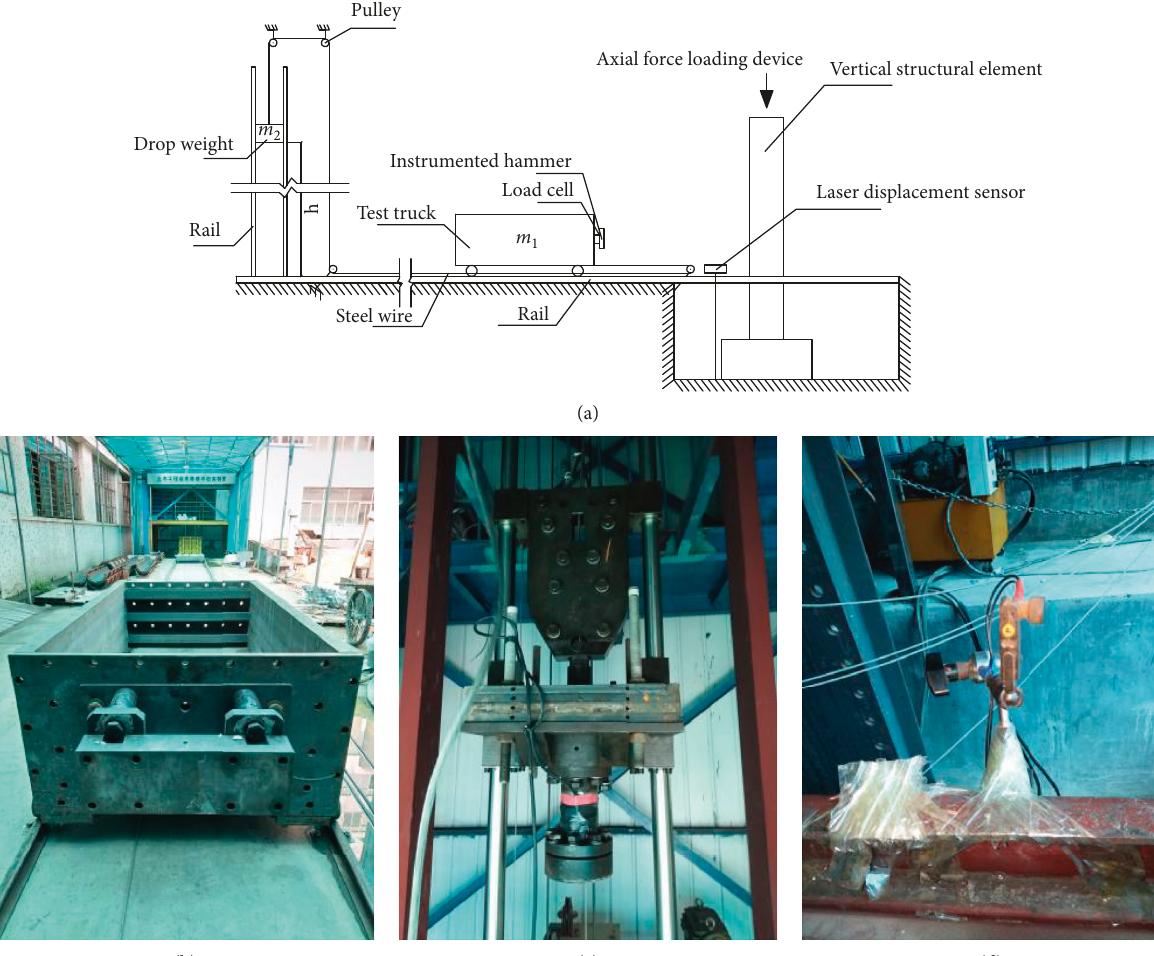
Figure 1: (a) Multifunctional ultrahigh heavy drop hammer testing machine system, (b) horizontal traction impact testing cart, (c) vertical drop hammer device, and (d) laser velocimetry.